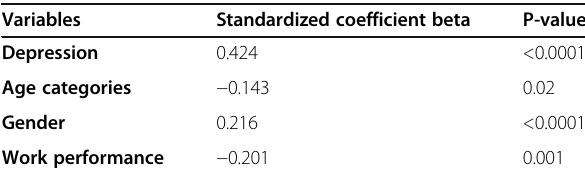
Table 4 Linear regression model for perceived